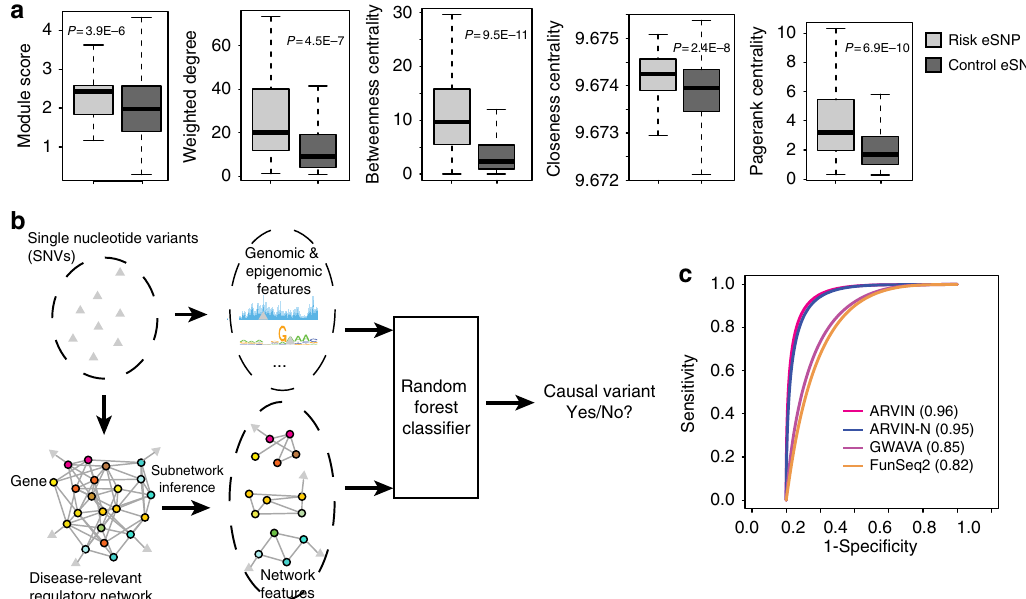
Fig. 2 ARVIN combines genomic, epigenomic, and network features to prioritize risk SNPs. a Network features extracted from a disease-relevant gene regulatory network are discriminative. P values are based on t test. b Overview of ARVIN. c Receiver Operating Characteristic (ROC) curves using known risk SNPs located in gene promoters. Values in parenthesis are area under the ROC curve. P values are computed using a bootstrap-based method 55 . ARVIN-N ARVIN using network-based features